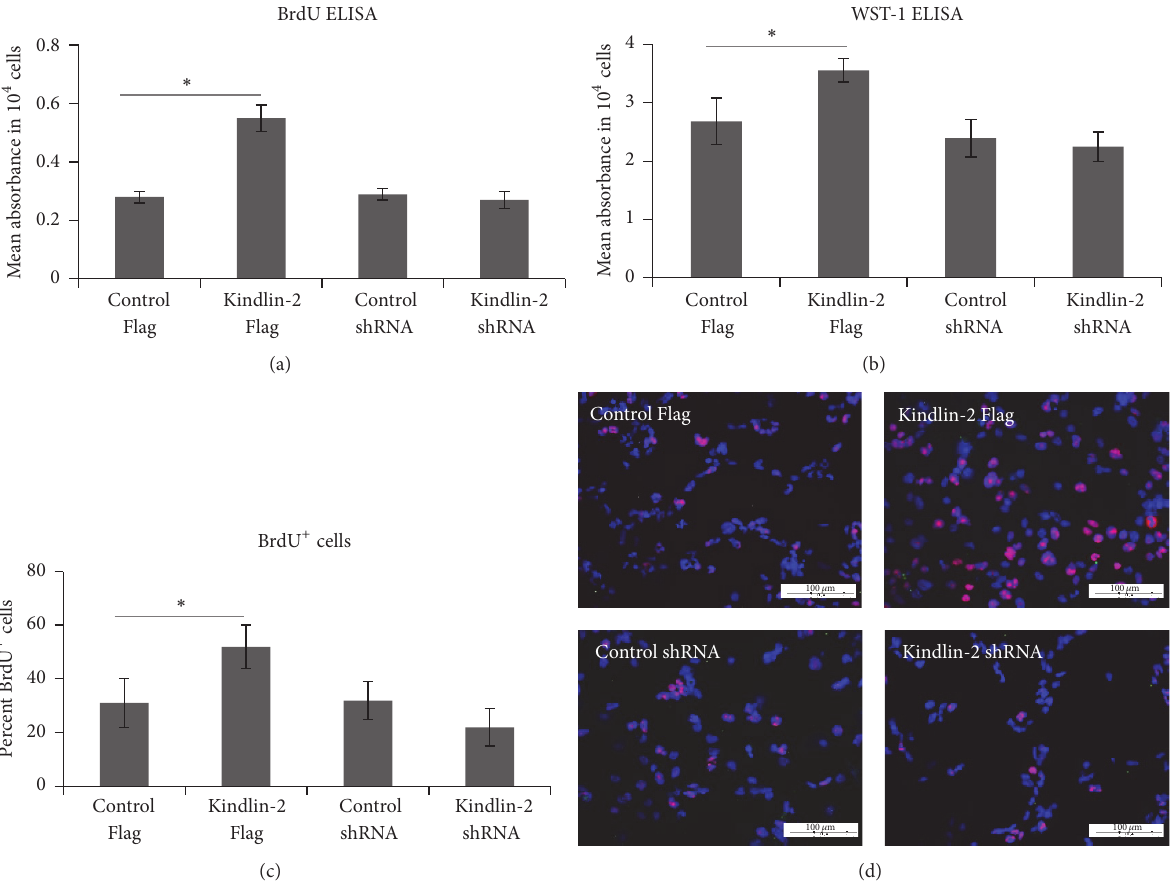
Figure 2: Kindlin-2 regulates iPSC-MSCs cell growth. Cell growth was measured with BrdU (a) and WST-1 (b) ELISA assays and indicated a significantly higher proliferation potential of Kindlin-2 overexpressing cells. BrdU + cells were counted 5 days after transfection and showed a significantly higher percentage of BrdU + cells in Kindlin-2 overexpressing cells compared to control Flag (c and d). DAPI was used as a counterstain. ∗ Significance difference between the indicated groups 𝑝 ≤ 0.05